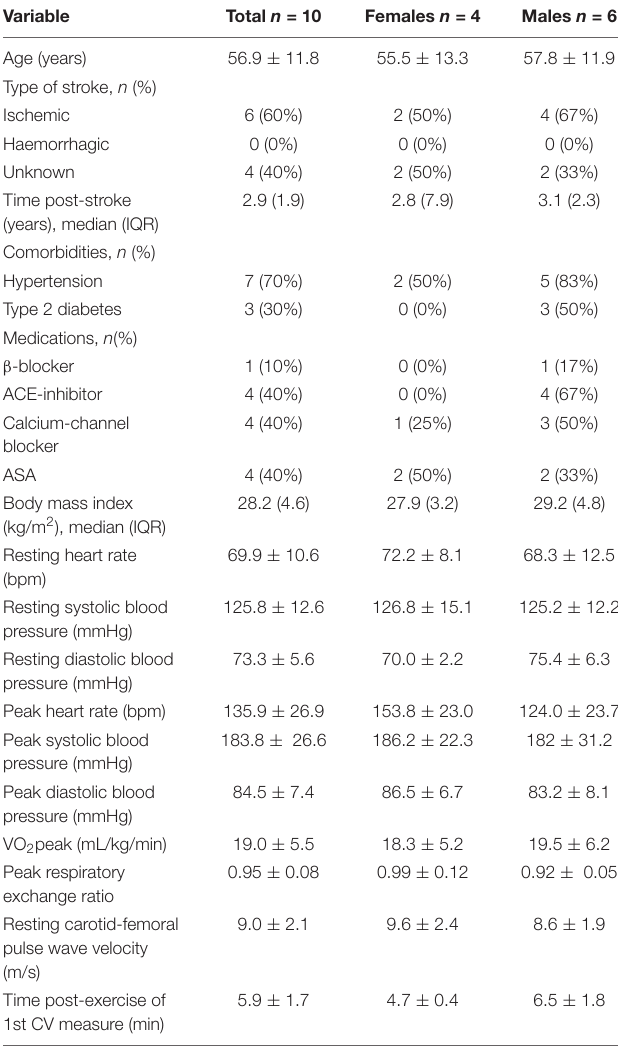
TABLE 1 | Participant characteristics for entire sample ( n = 10) and disaggregated by sex.